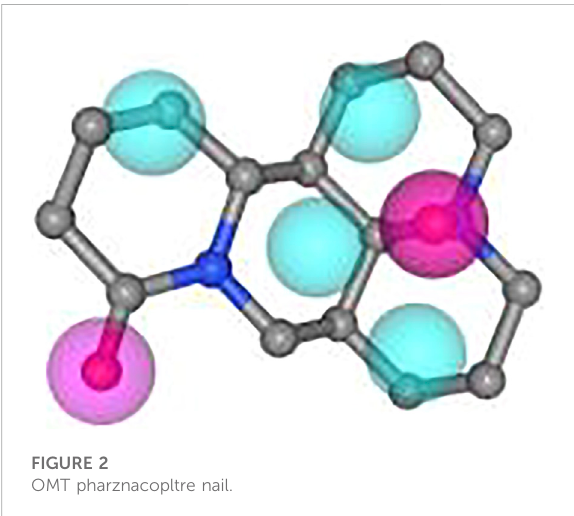
FIGURE 2 OMT pharznacopltre